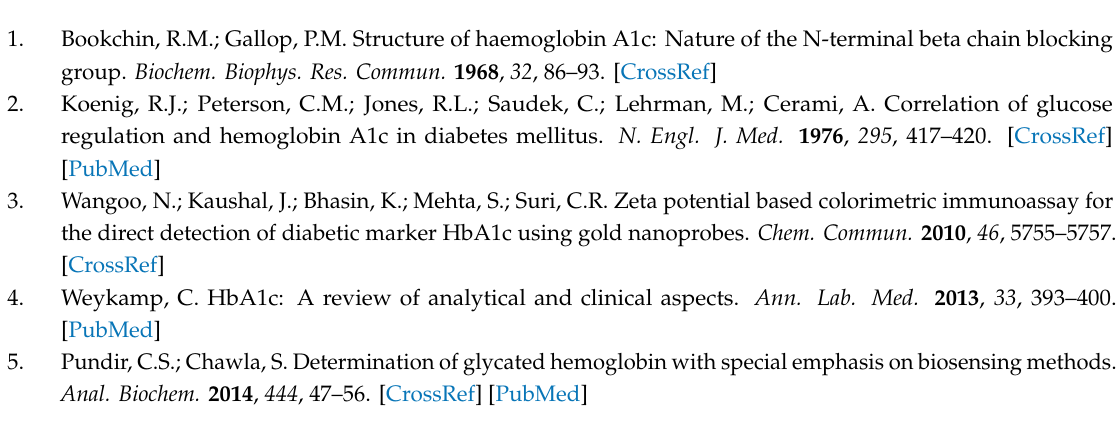
Figure S1: Adsorption isotherms, Figure S2: Immunofluorescence analysis for a HbA0-coated HbA0 aptasensor, Figure S3: De-convoluted Raman spectra for various coated ITO electrodes, Figure S4: Cross reactivity between HbA0 and HbA1c aptasensors, Figure S5: AFM topographic images of the b-PM layer on mica after storage in 10 mM PB containing 100 mM NaCl at pH 8.0 and 4 ◦ C for di ff erent days, Figure S6: Relative total photocurrent density of various chips after storage for di ff erent days, Table S1: Raman-band (cm − 1 ) assignment for ITO electrodes that are fabricated with di ff erent top layers, Table S2: Decrease in photocurrent for HbA0 and HbA1c aptasensors after incubation with various substances at the specified concentrations, Table S3: Comparison of various aptamer-based HbA1c assay